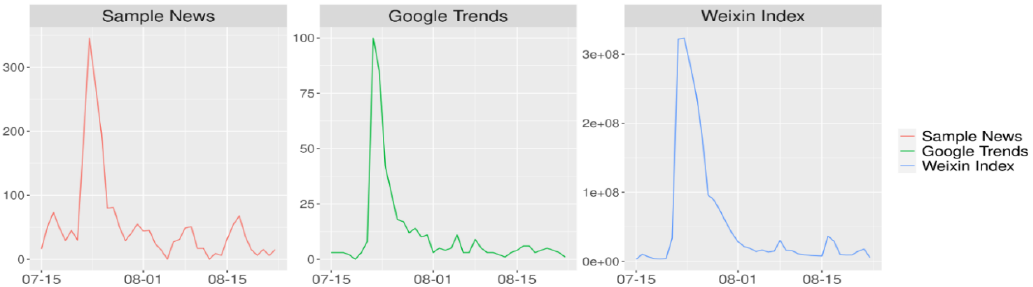
Figure 2. Temporal trends of the news reports included in the study with the corresponding Google